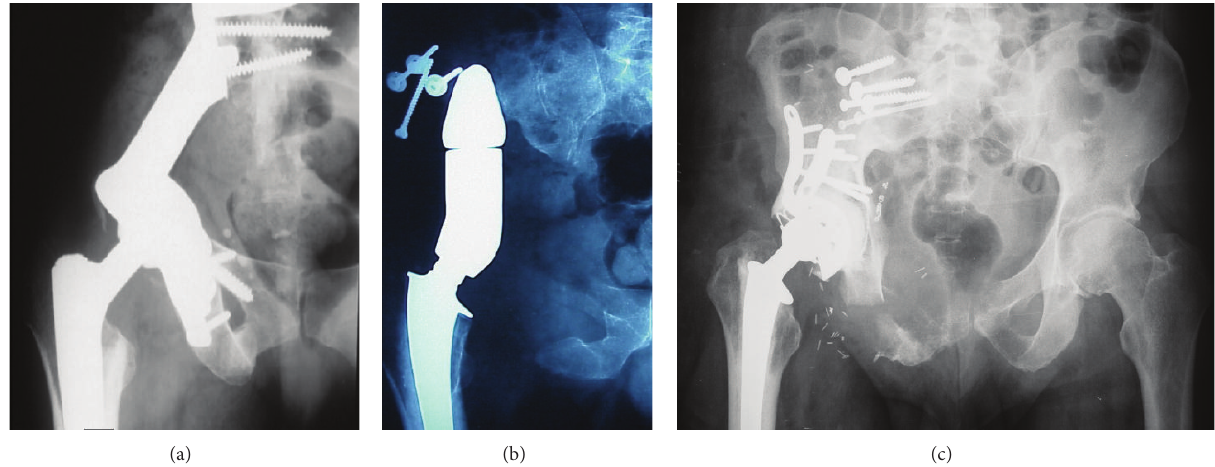
Figure 3: Different reconstruction techniques after wide resection of a periacetabular lesion. (a) Megaprosthesis; (b) saddle prosthesis; (c) massive allograft with total hip